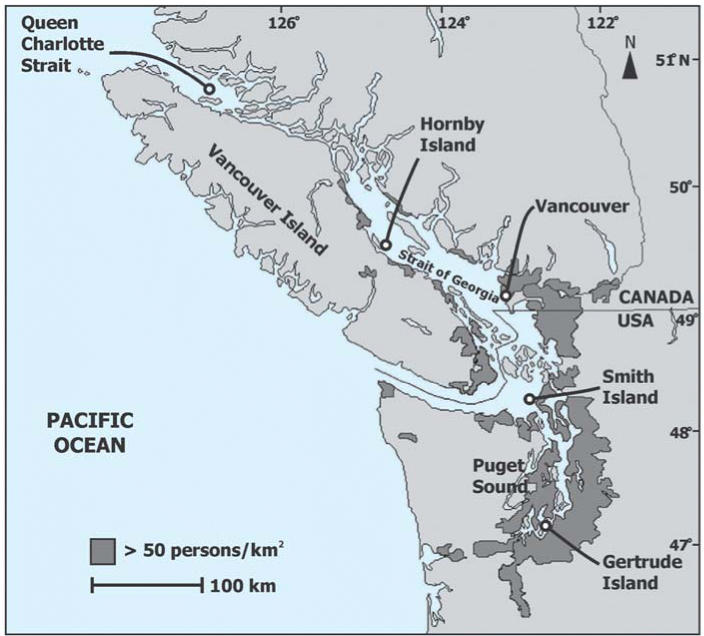
Harbor seal pups were live-captured from three sites (Queen Charlotte Strait, Hornby
Island, and Vancouver) in British Columbia, Canada, and
two sites (Smith Island in Juan de Fuca Strait and Gertrude Island in
Puget Sound) in Washington State, USA. Human population densities > 50 persons/km2 are a proxy for possible regional contaminant sources. From State of Washington
Office of Financial Management (2000) and Statistics Canada (2001).